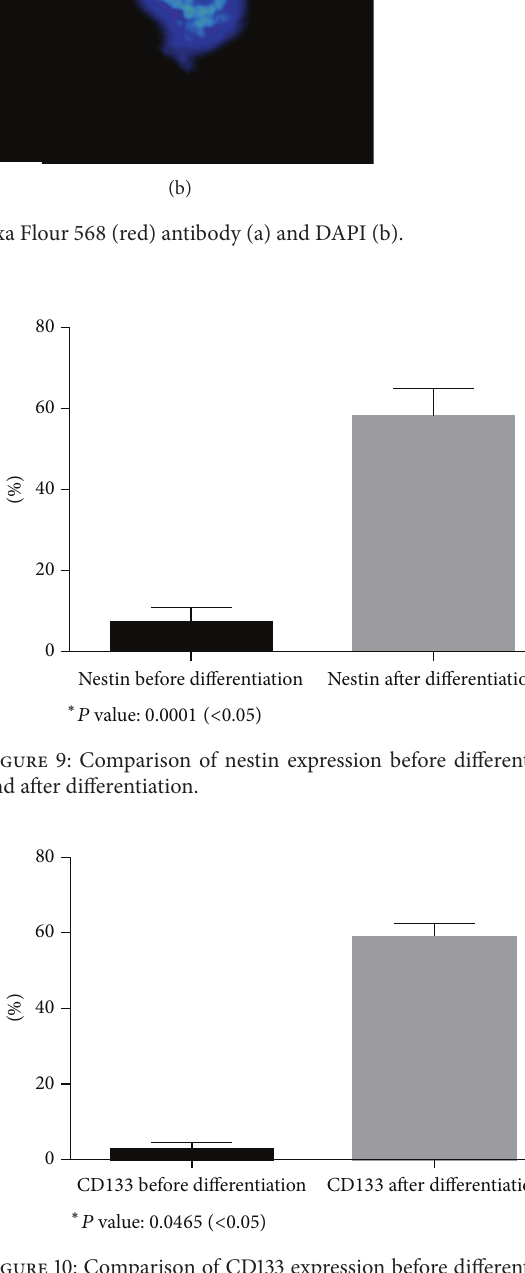
Figure 10: Comparison of CD133 expression before differentiation and after